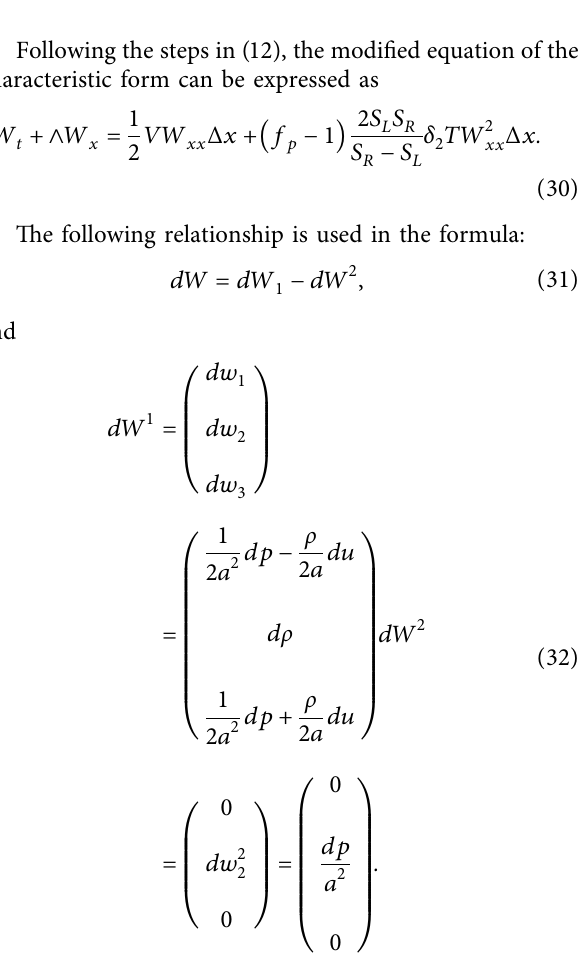
Figure 3: Convergencecurveofresidualvalueofone-dimensional steady-stateshock problemcalculatedby theHLLEMschemeundertheconditions � 6.0 and ε � 0.3. (a) HLLEM-p format is applied to the interface of grid M. (b) HLLEM-p format is applied to the interface of grid M of M 0